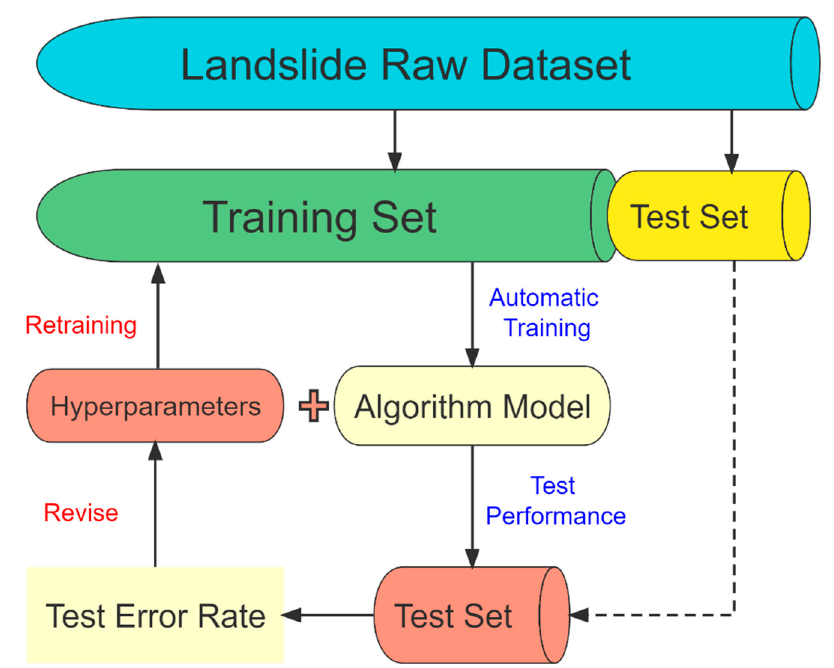
Figure 16. Computational flowchart for model space datasets.